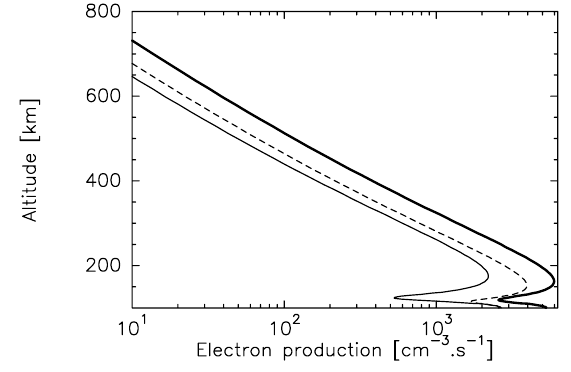
Fig. 2. Electron production rate associated with the continuum (dashed line) and the set of 16 spectral lines used in XUV/EUV aeronomical models (thin full line). The total production is shown in a thick full